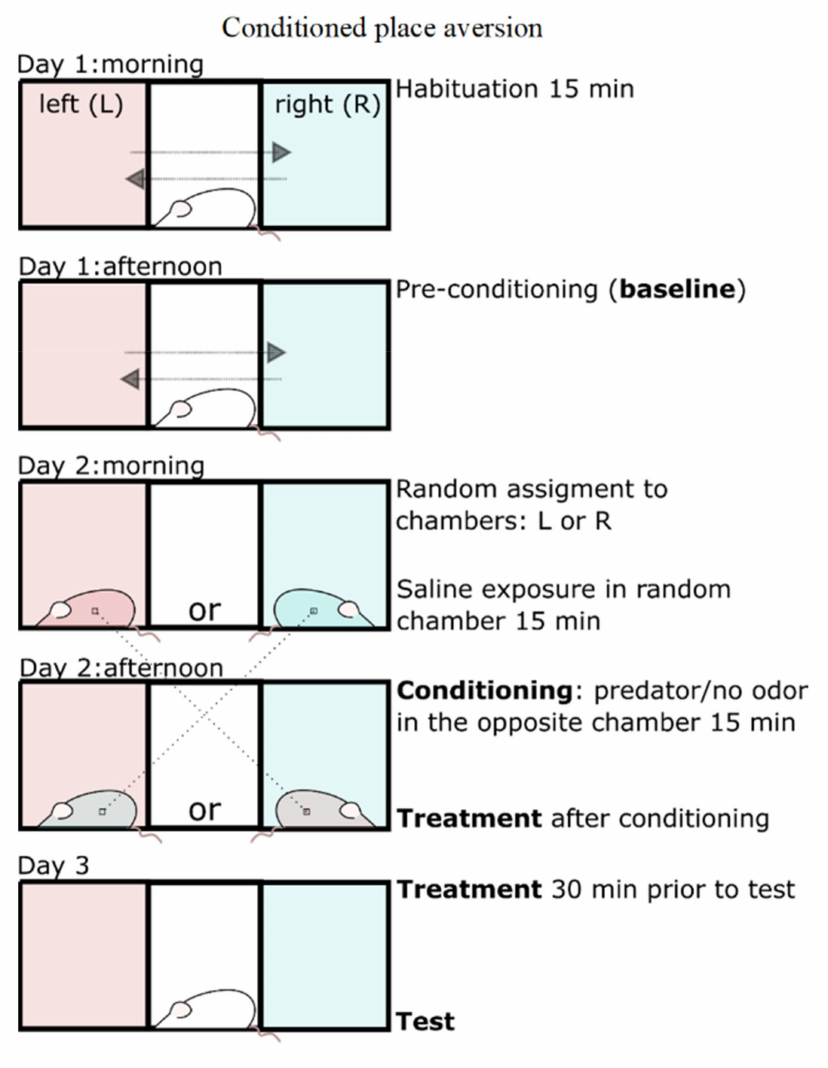
Figure 7. Scheme of the POCPA